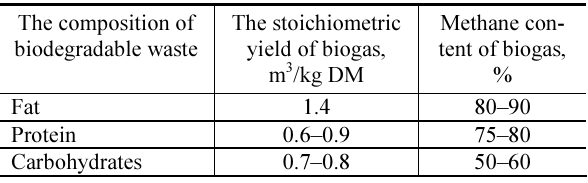
Table 1. Stechiometric output of biogas and the content of methane in it (Budrys 2006) The composition of biodegradable